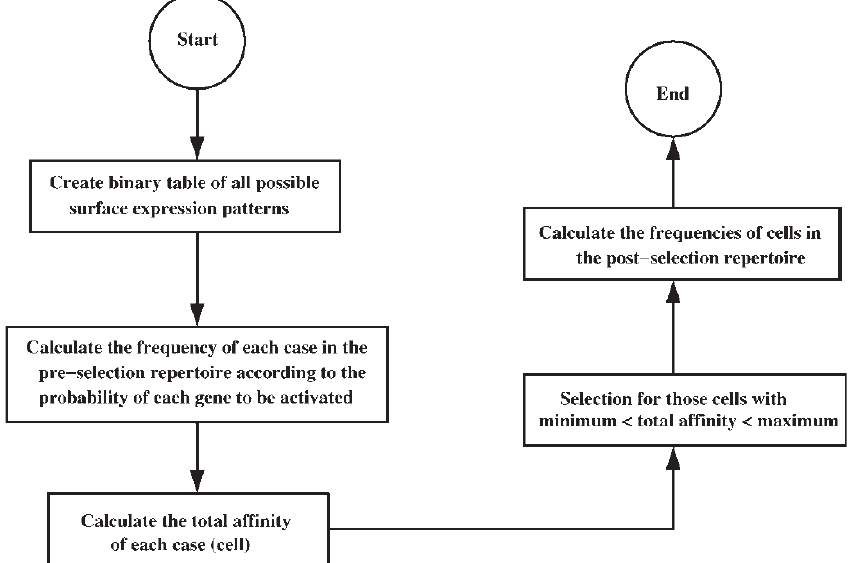
FIGURE 3 Flow chart of the program implementing the two-step selection model. (The program is available from the authors upon